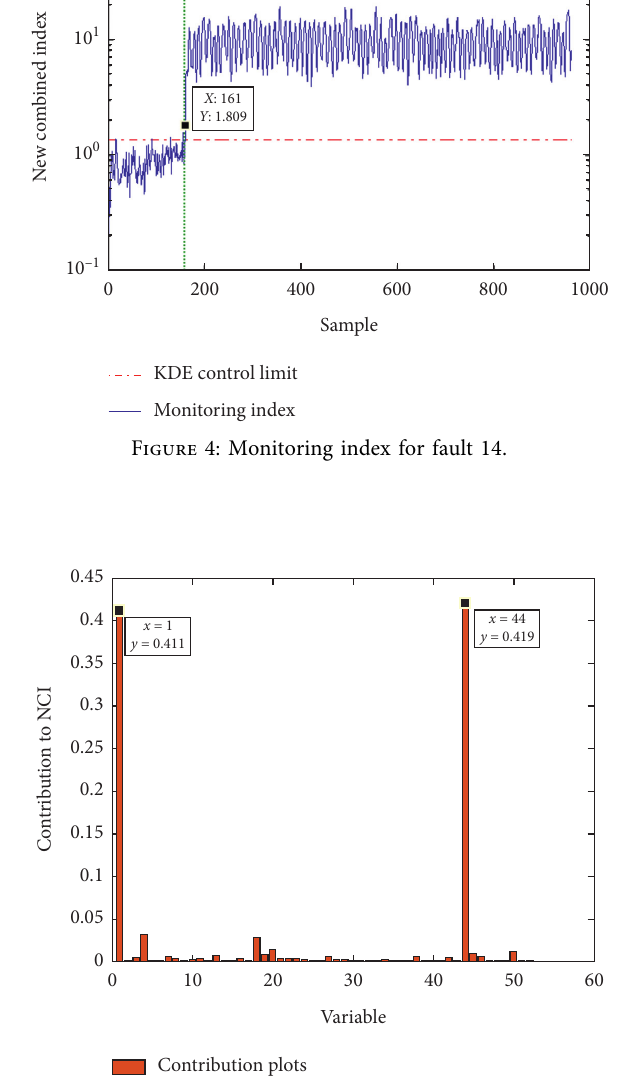
Figure 5: NCI-based contribution plot for fault